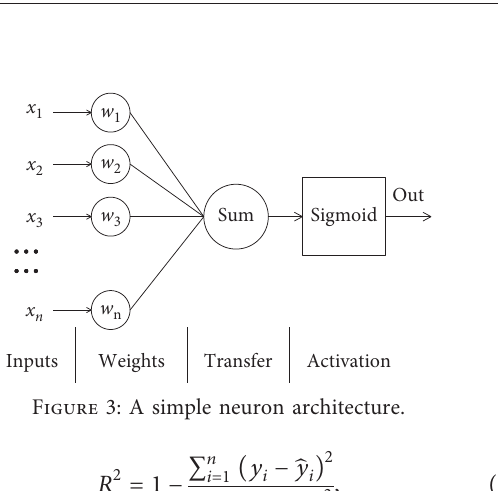
Figure 3: A simple neuron